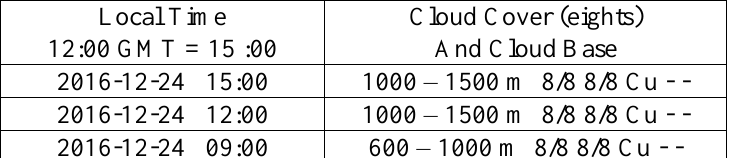
Table 8: Surface weather forecast for